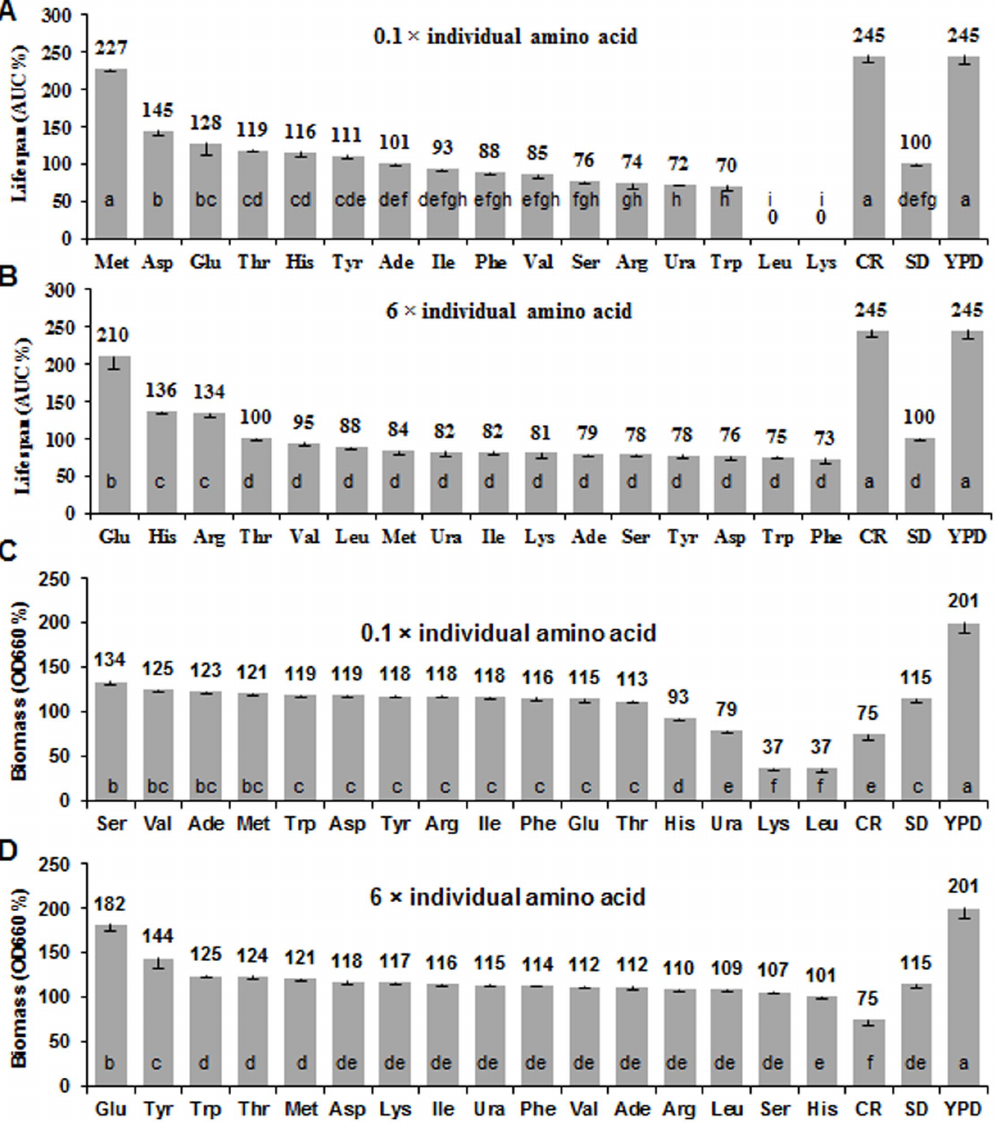
Figure 4. Effect of individual amino acids on yeast lifespan and biomass production. Lifespan comparison of wild type yeast was grown in SD media with individual amino acid restriction ( A ) or addition ( B ). The biomass productions were shown in C and D , respectively. To reduce (0.1- fold) or increase (6-fold) single amino acids in SD medium, the other amino acids concentrations were held constant. SD is standard medium with 2% glucose as the control condition in this study ( Table 1 ); CR is SD medium with 0.5% glucose as the calorie restriction condition; YPD is a commonly used nutrient-rich medium with 1% yeast extract, 2% peptone and 2% dextrose. The concentrations (1 fold) of individual amino acids were listed in Table 1 . AUC represents the survival integral for CLS comparison and AUC of the SD medium was defined as 100%. Biomass of the SD medium was defined as 100%. Data are expressed as mean 6 s.e.m. (n=6); comparison were made using Duncan’s multiple range test at P , 0.05 and different lowercase letters in columns indicate significant